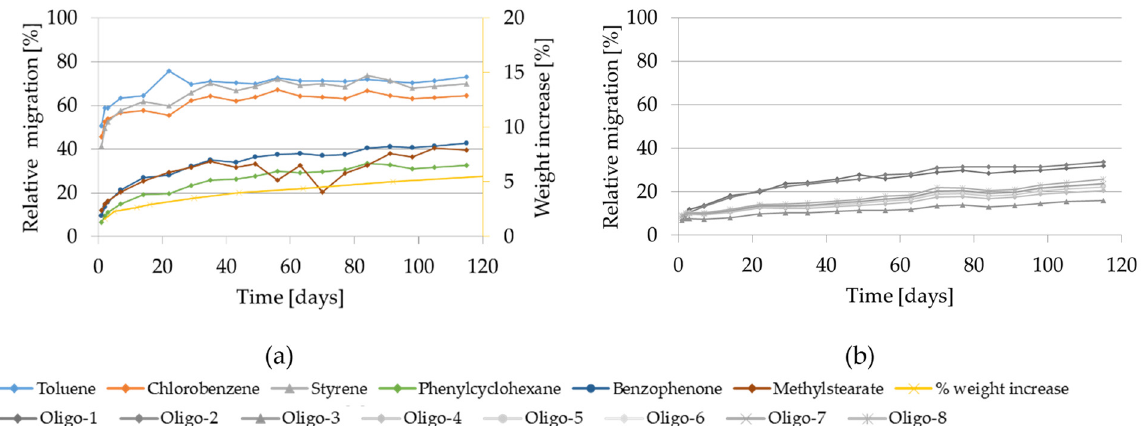
Figure 3. Migration and swelling kinetics in isooctane at 20 °C from HIPS: ( a ) Model substances and styrene; ( b ) Styrene oligomers.